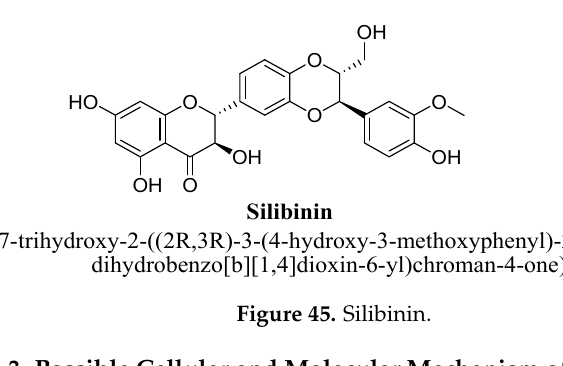
Figure 45. Silibinin. Figure 45.